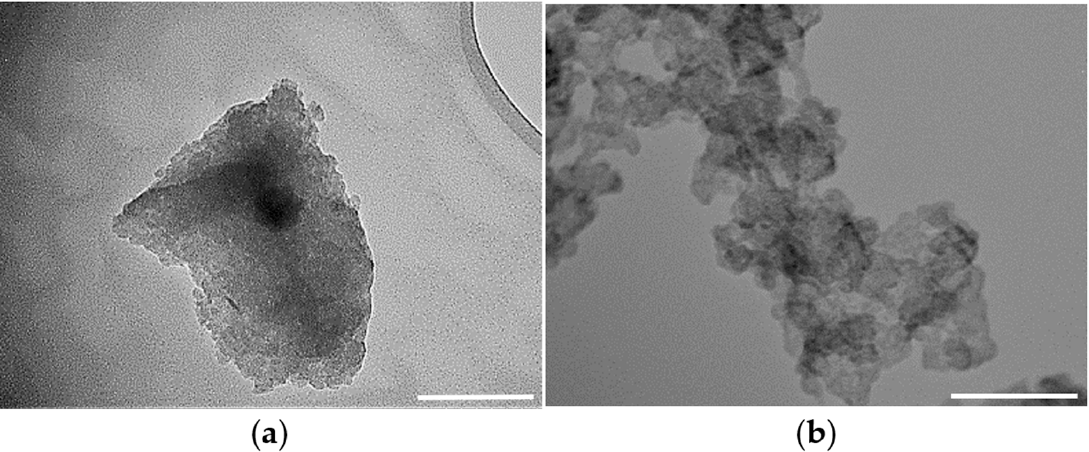
Figure 3. TEM micrographs of the pristine ( a ) meso-UiO-66 (scale bar is 200 nm) and ( b ) meso-NH 2 - UiO-66 (scale bar is 50 nm) materials.